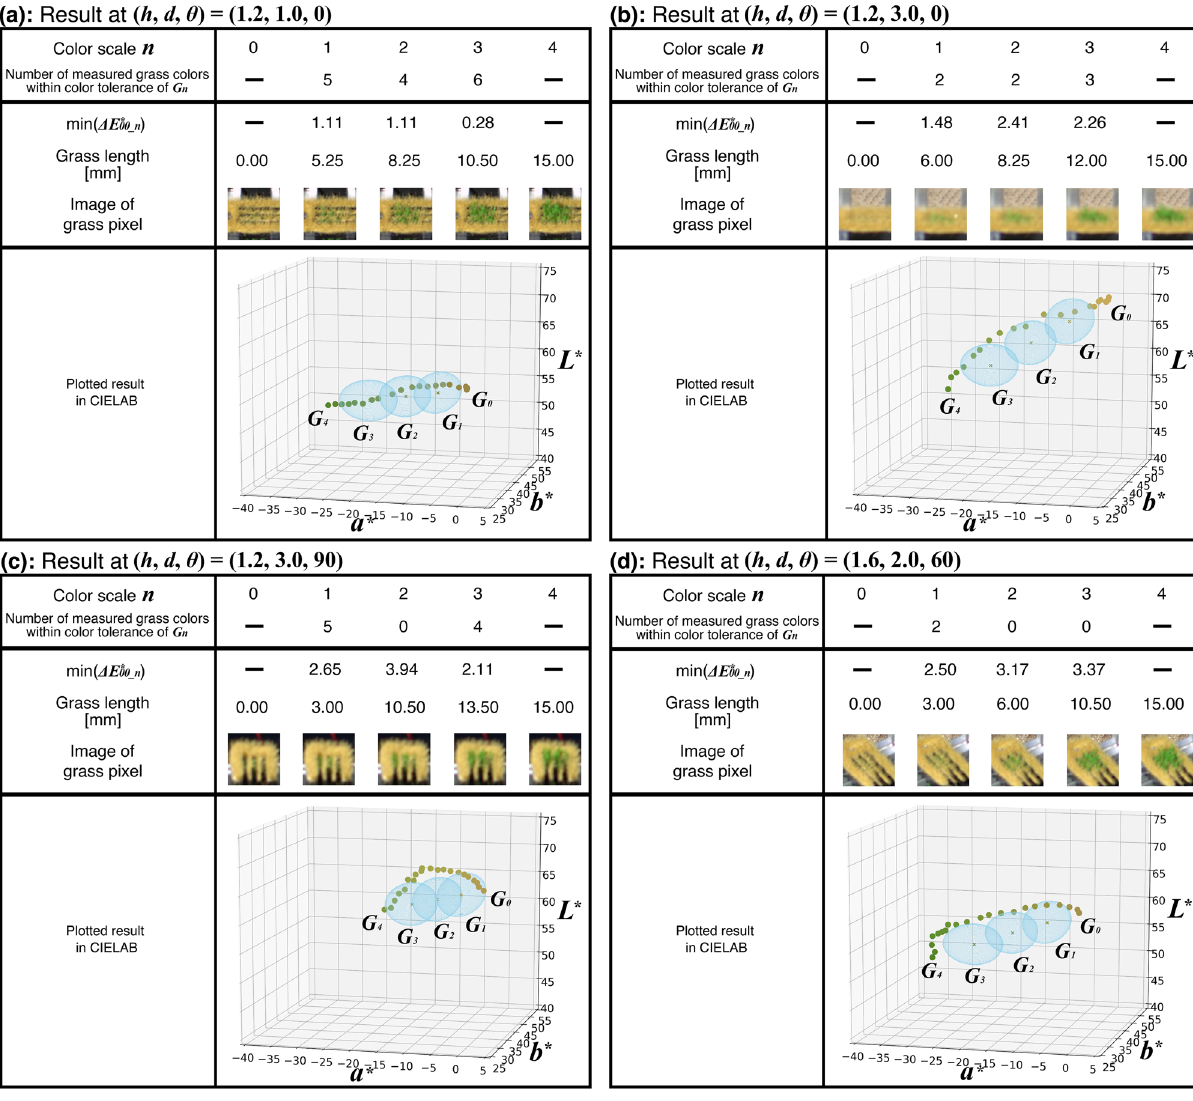
Figure 7. Examples of experimental results of grass color scale setting procedure. ( a , b ) Results at ( h , d , θ) = ( 1.2, 1.0, 0 ) and (1.2, 3.0, 0) were successful to map the green grass length corresponding to the color scale. ( c , d ) Results at ( h , d , θ) = ( 1.2, 3.0, 90 ) and (1.6, 2.0, 60) failed due to the influence of the slits of the grass pixel. This figure was created using Serif Affinity Designer version 1.10.0 (https:// affin ity. serif. com/ en- us/) and Matplotlib version 3.2.2 (https:// matpl otlib.